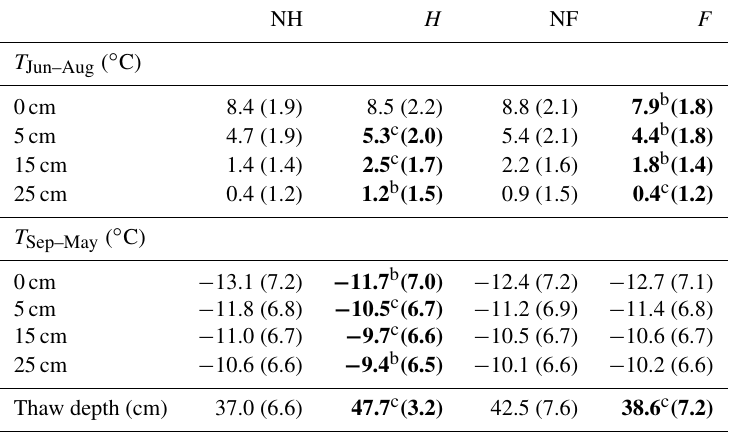
Table 1. Average soil temperature (standard deviation) and average thaw depth (standard deviation) of the five experimental blocks for plots grouped into no-fertilization (NF) and fertilization treatments ( F ). Data are grouped by growing season ( T Jun–Aug ) and no-growing season ( T Sep–May ) and depth (0, 5, 15 and 25cm). Significant effects are in bold. NH